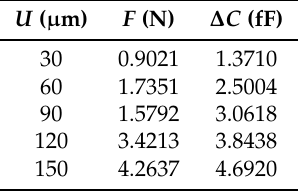
Table 1. Experimental results associated with the application of normal force reported in